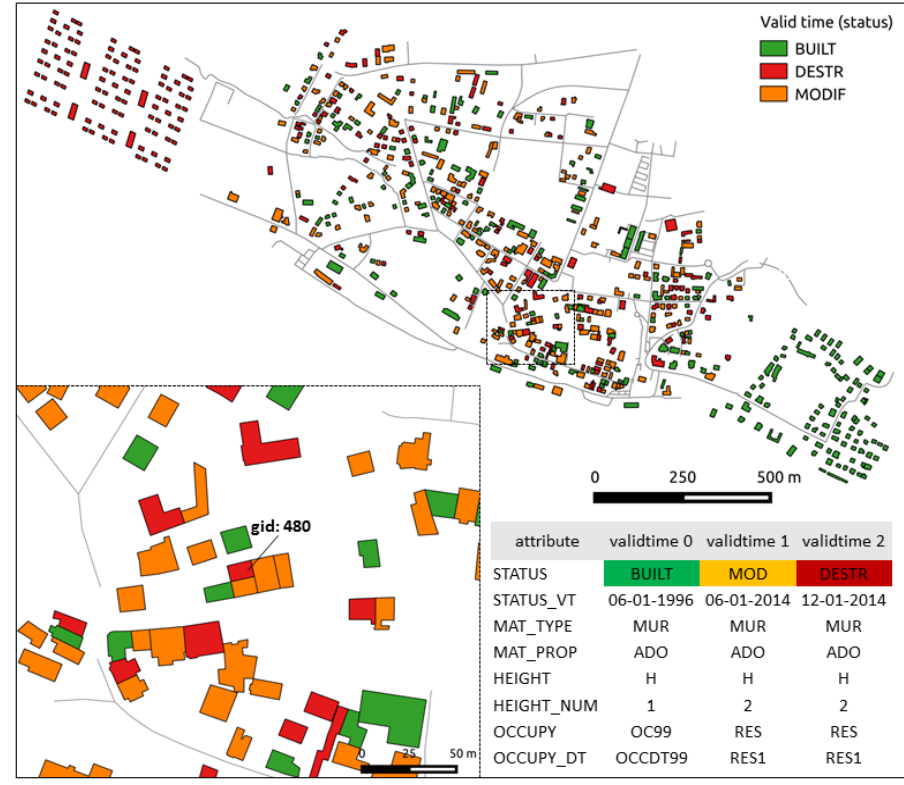
Figure 9. Valid time history of the database, which includes for each object an information lifecycle with the type of real-world change, valid time of the changes, and recovered attributes at any given valid time. The magnified view and table show the lifecycle of a selected object.